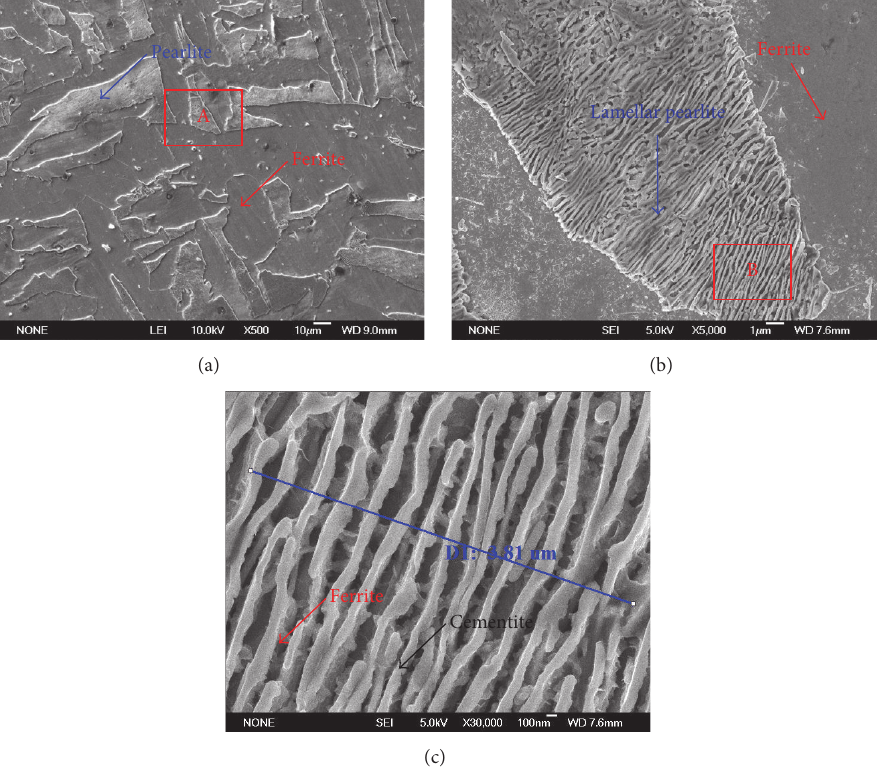
Figure 4: Typical FE-SEM micrographs of the 1045 carbon steel after annealing at 873 K (600 ∘ C) for 4 h ((b) is the higher magnification of the A region in (a); (c) is the higher magnification of the 𝐵 region in (b)).